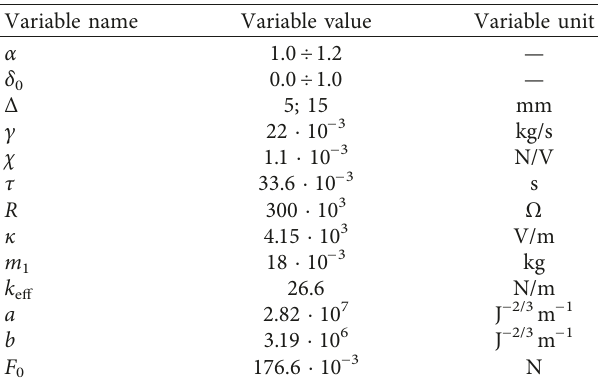
Figure 2: The potential energy U of oscillators versus oscillating mass displacements x 1 , x 2 for different values of air gap thickness ∆ . Inset: the potential energy versus parameter ∆ at x � 0 in the normalized case (solid line) and without normalization (dotted line). Table 1: The parameters used in our